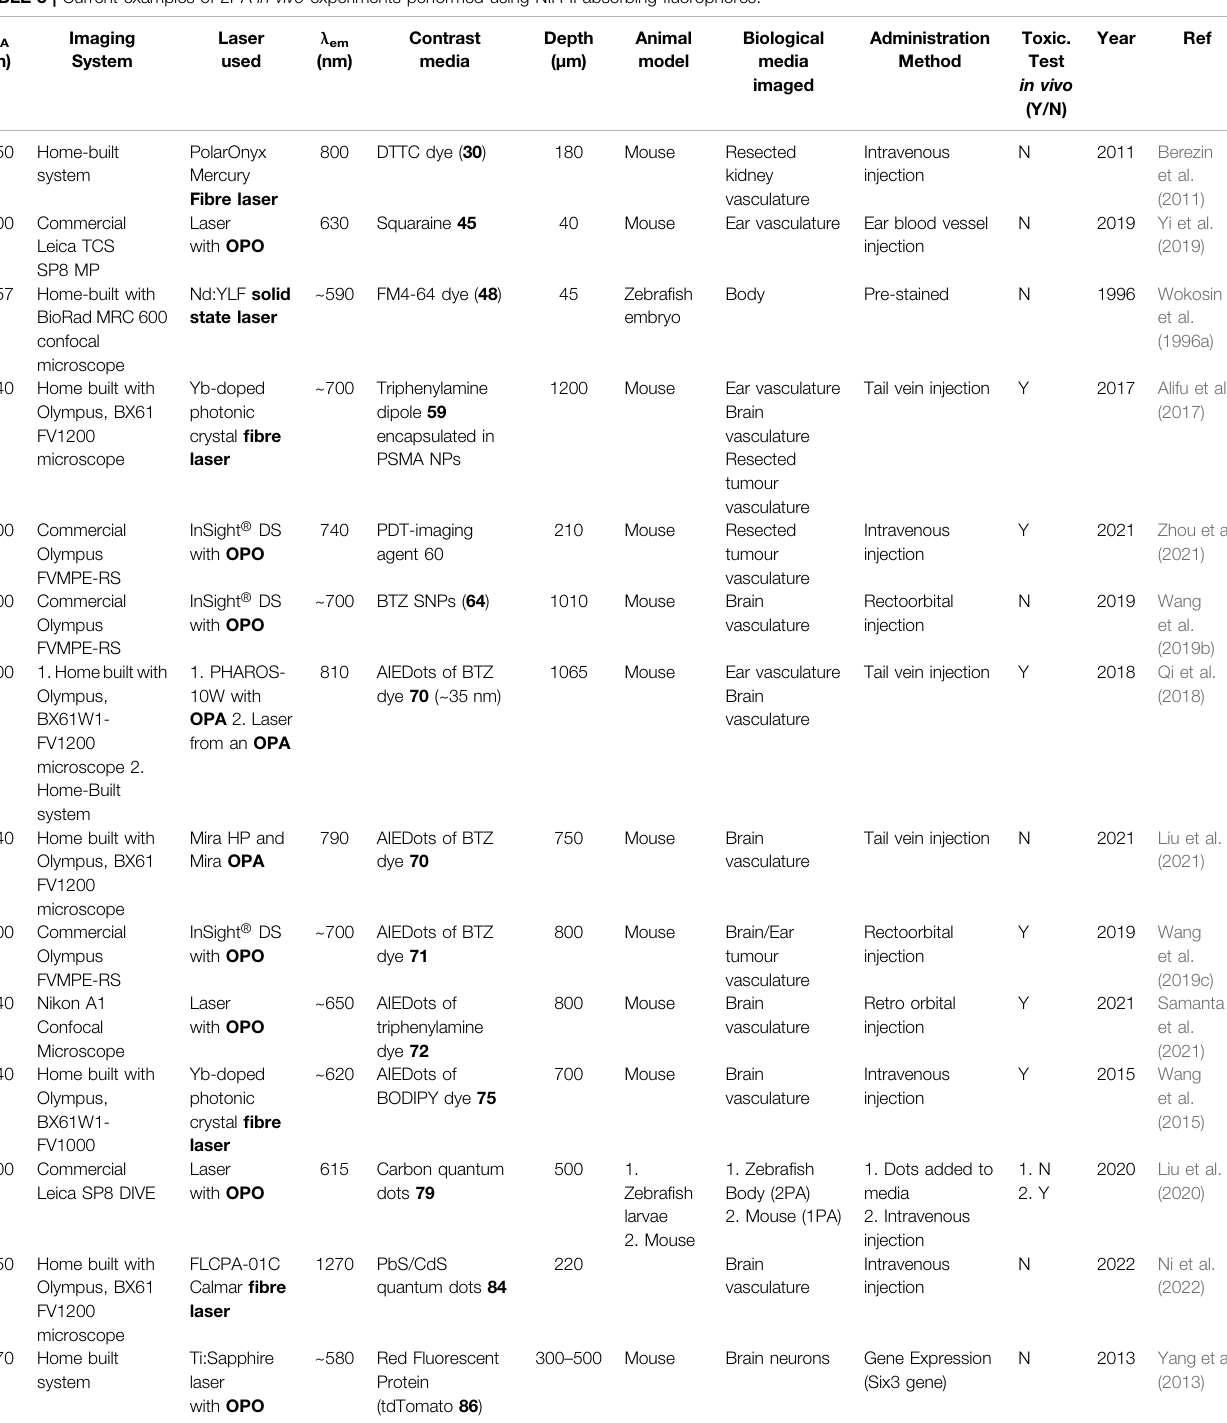
TABLE 3 | Current examples of 2PA in vivo experiments performed using NIR-II absorbing fl